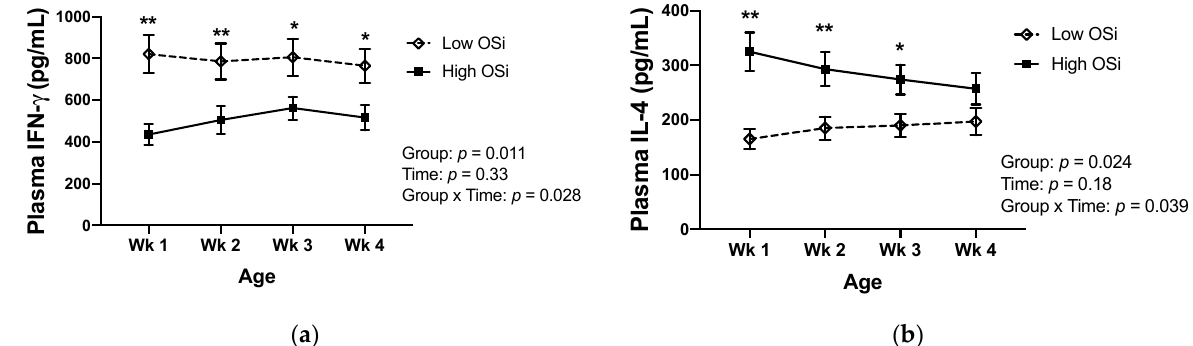
Figure 2. Changes in plasma concentration of ( a ) interferon-gamma (IFN- γ ) and ( b ) interleukin (IL) 4 in calves throughout their first 4 weeks of life, according to their classification in the oxidant status index (OSi) groups ( n = 6/group). The “low OSi” group includes the 6 calves with the lowest average OSi values based on weekly measurements. Results are expressed as estimated means ± SE. * p < 0.05, ** p < 0.01.